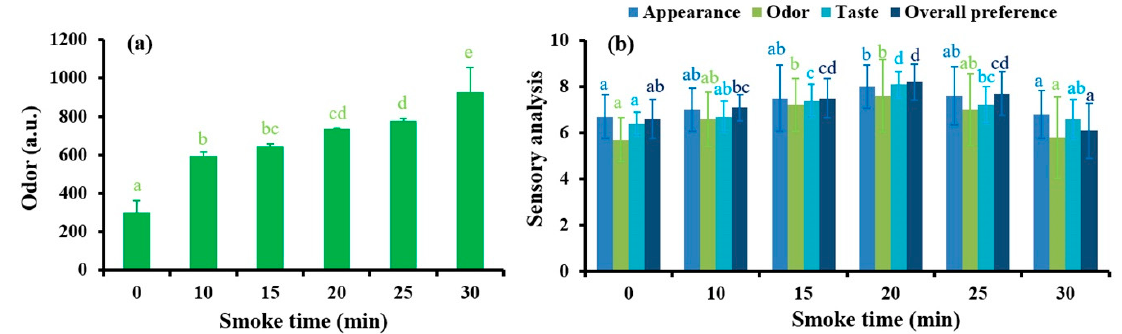
Figure 2. Changes of odor intensity ( a ), and sensory quality ( b ) in CM fillet with different smoke times (0, 15, 20, 25, and 30 min) by oak sawdust. The data were stated as mean ± std ( n = 10), where different letters were statistically different ( p <